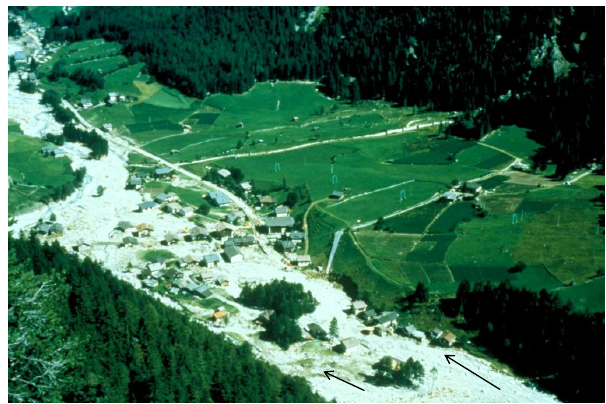
Figure 2. Consequences and extent of the debris flow on the 24th of August, 1987 2 Fig. 2. Extent of the debris flow on 24 August 1987 (Municipality (Municipality Martell, 1987). The arrows indicate the flow direction. 3 Martell, 1987). The arrows indicate the flow